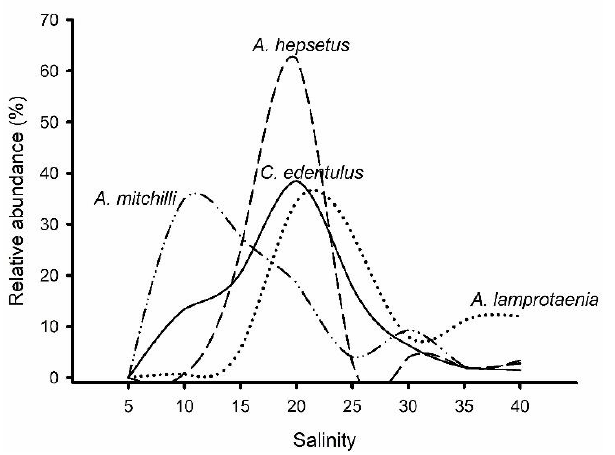
Figure 5. Percentage of captured individuals of each species, in relation to their own total abundance, according to a salinity gradient.